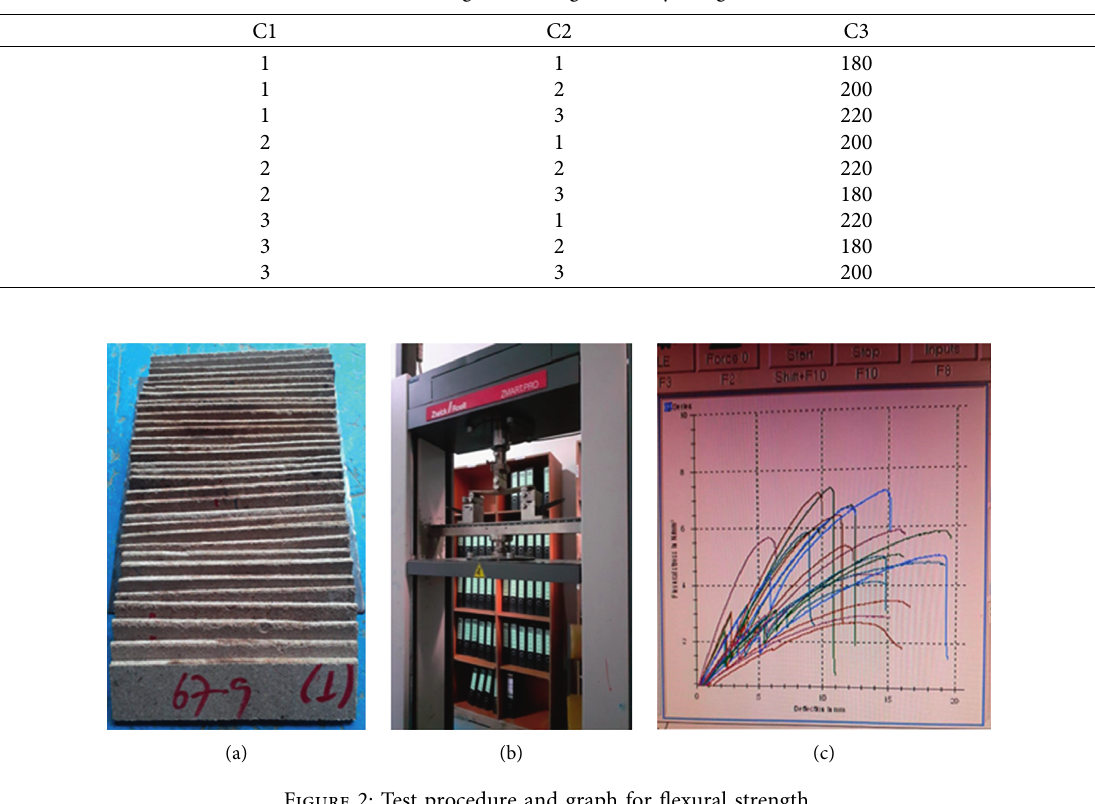
Table 2: Taguchi orthogonal array